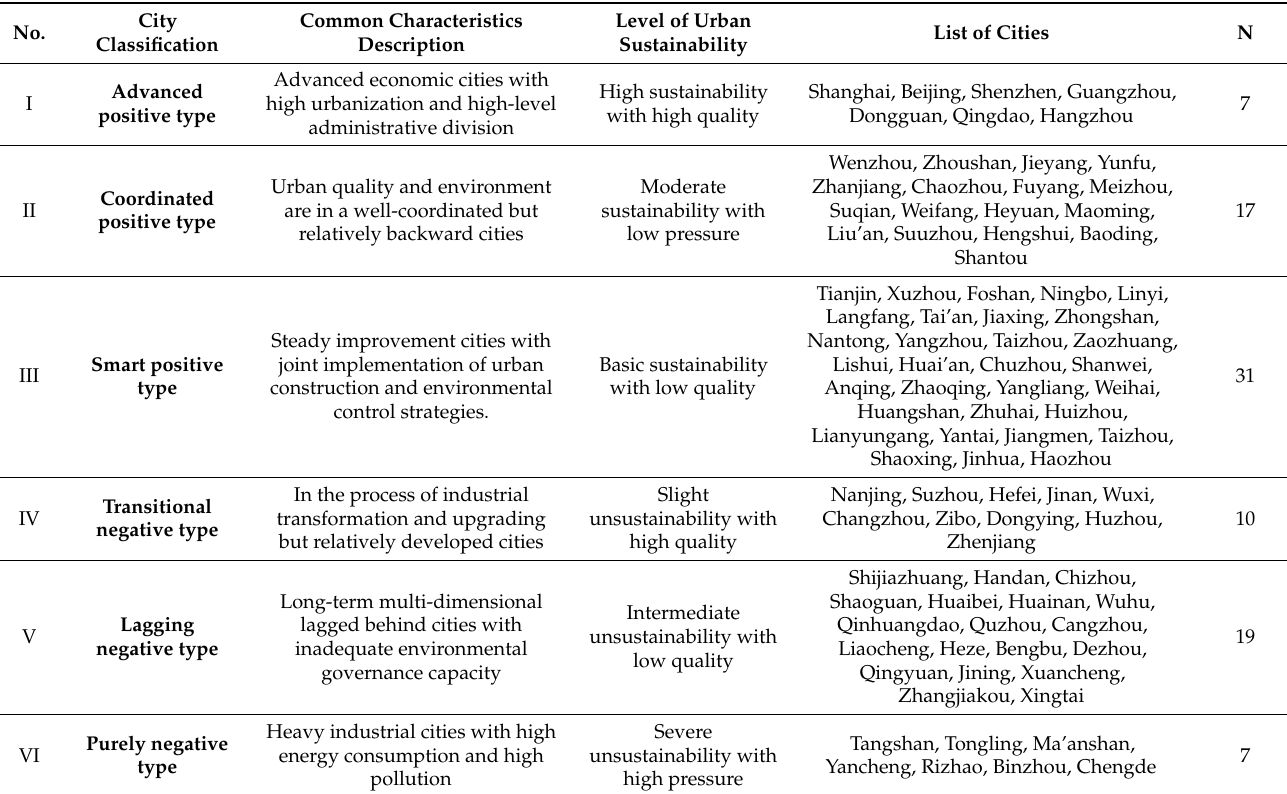
Table 4. List of cities by sustainability performance clustering